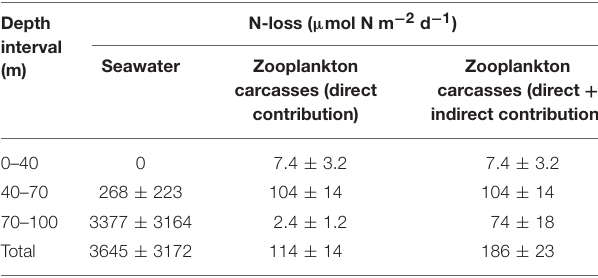
TABLE 1 | Depth-integrated rates of pelagic